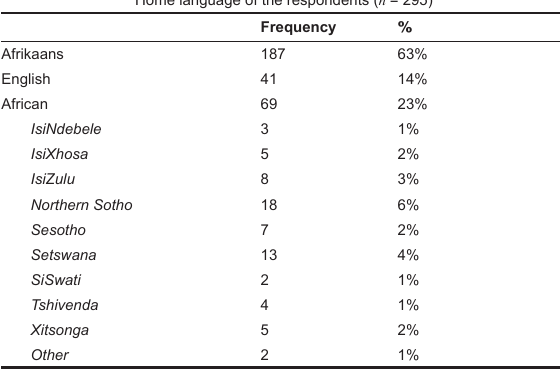
TABLE 1 Home language of the respondents ( n =